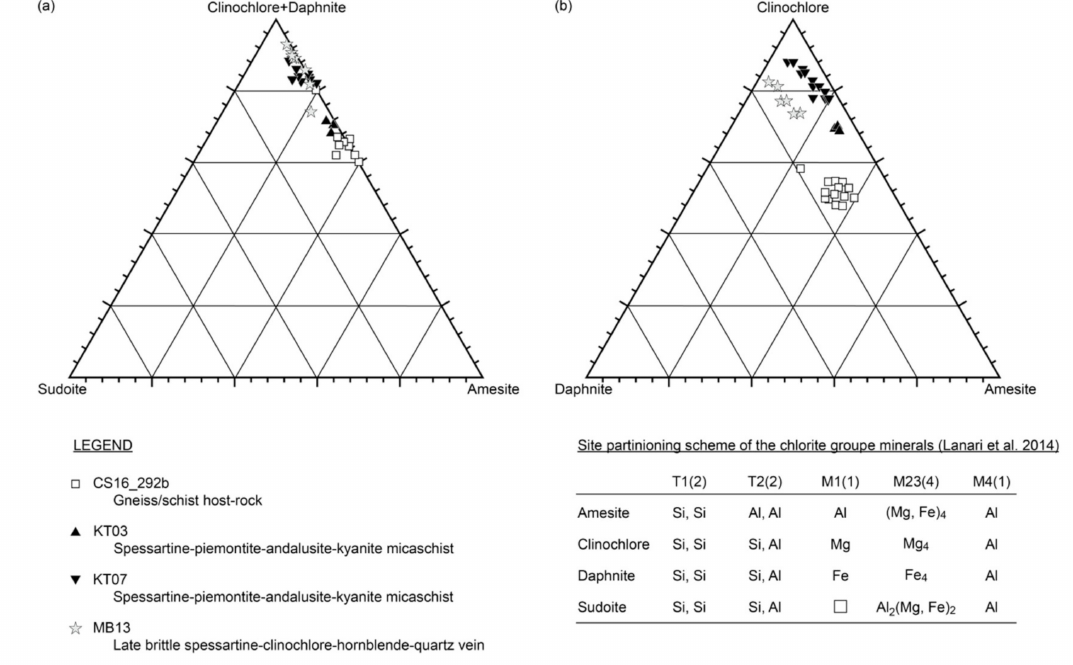
Figure A1. Composition of chlorite-group minerals analyzed by EPMA in ( a ) Clinochlore + Daphnite–Sudoite–Amesite and ( b ) Clinochlore–Daphnite–Amesite ternary plots. The mineral names are according the site partitioning scheme used in Lanari et al.